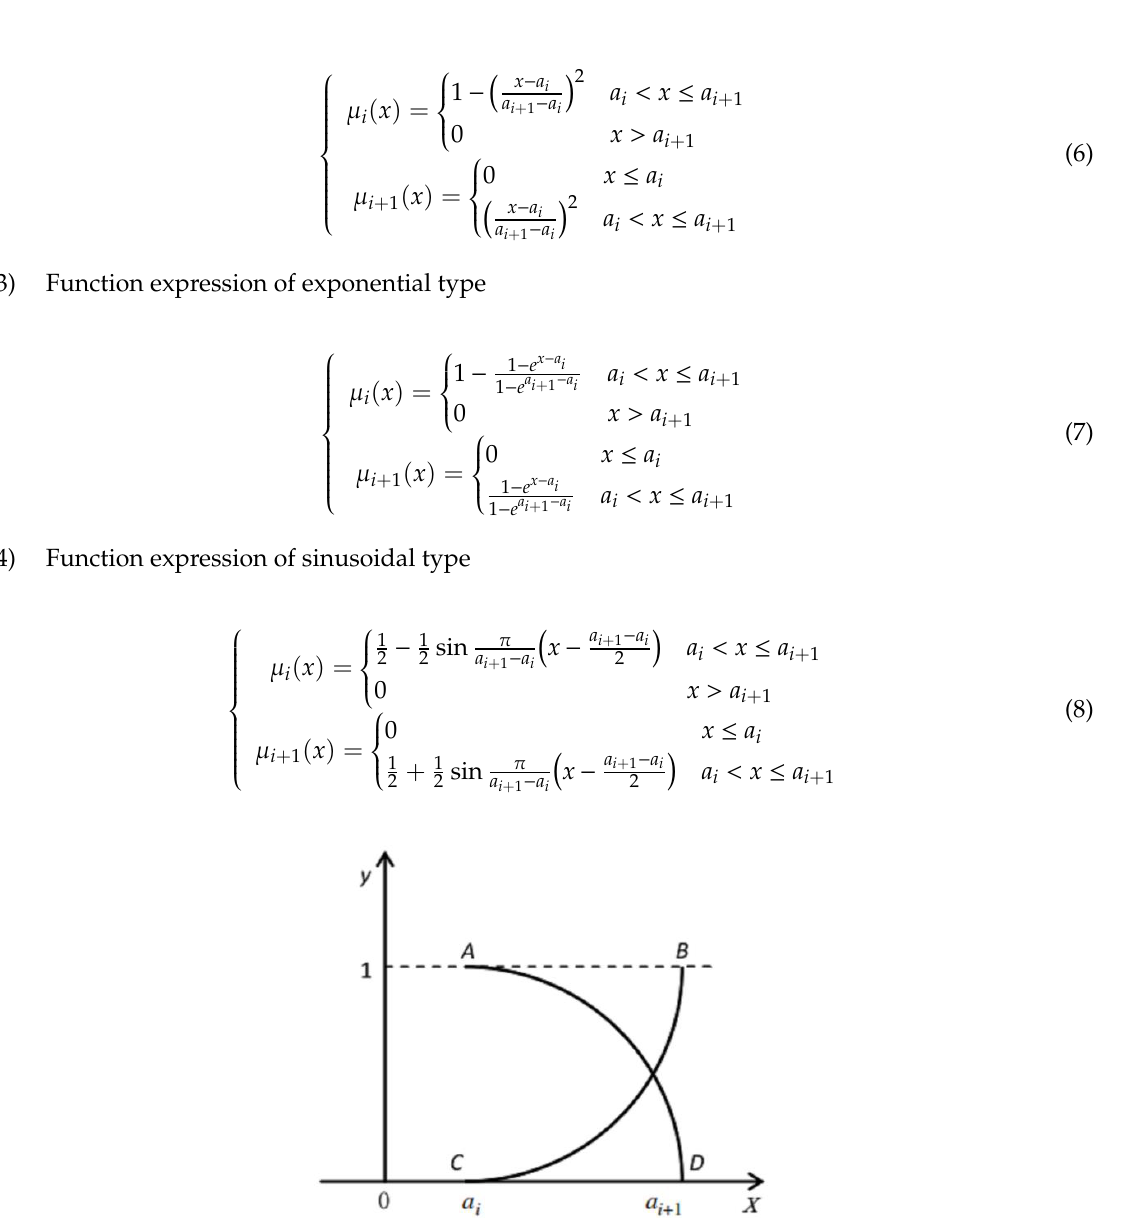
Figure 4. Sinusoidal-type